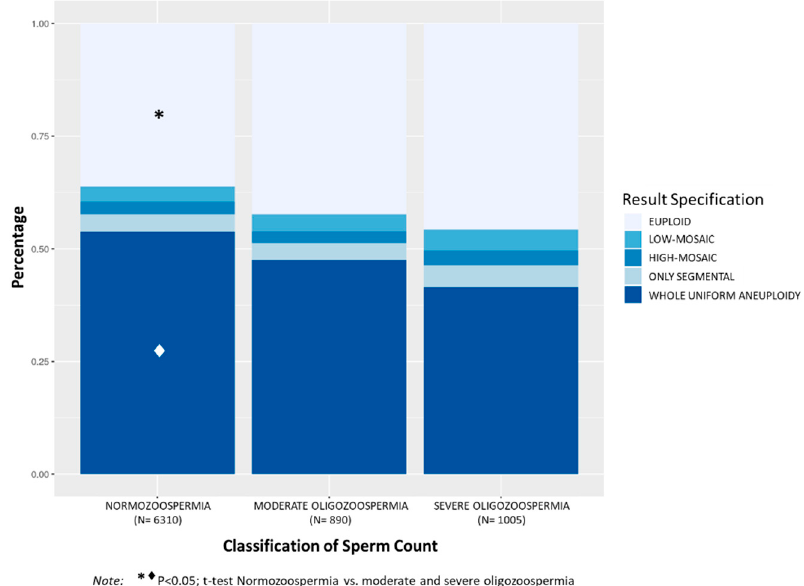
Figure 3. Distribution of the percentages of chromosomal abnormalities in TE biopsies (euploid, low-mosaic, high-mosaic, only segmental, and whole uniform aneuploidy) according to the classification of sperm count (normozoospermia, with ≥ 15 × 10 6 sperm / mL; moderate oligozoospermia, between > 5 × 10 6 and < 15 × 10 6 sperm / mL; severe oligozoospermia, with ≤ 5 × 10 6 sperm / mL). The mean number of embryos biopsied (SD) per case was 4.6 (3.2) for N category, 5.2 (4.1) for MO and 5.1 (3.7) for SO category.